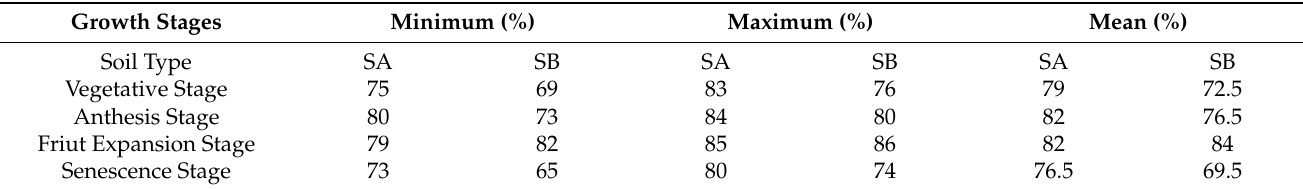
Table 4. Measured VWC at each growth stage.